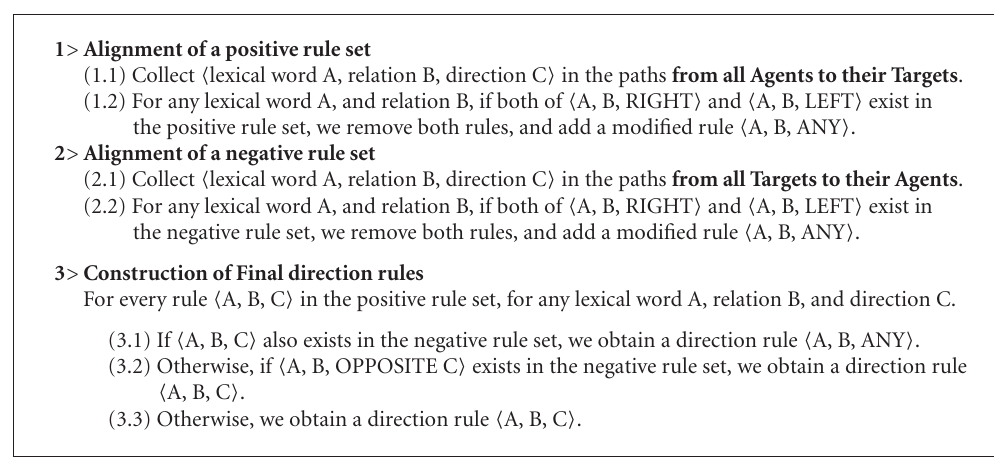
Algorithm 3: Direction rule-learning algorithm.